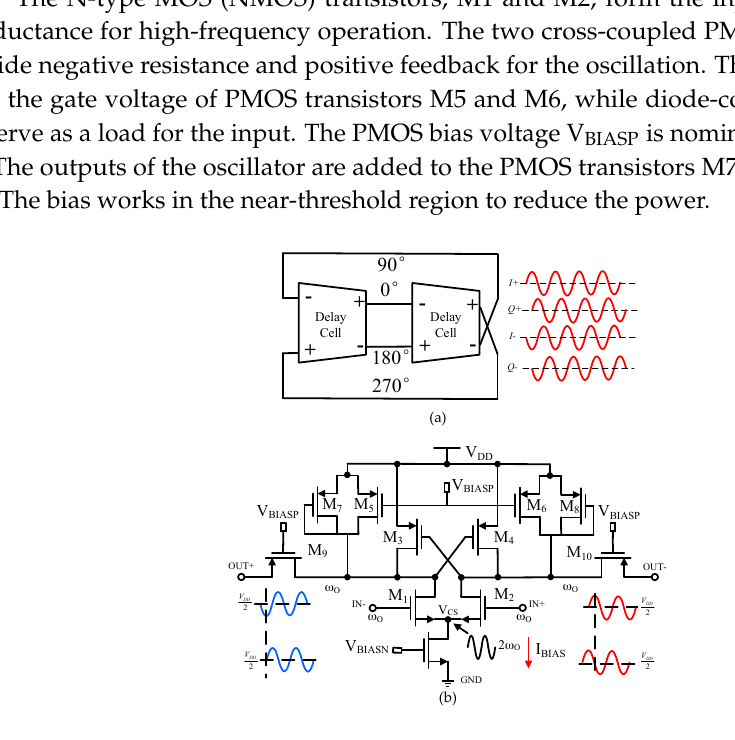
Figure 1. ( a ) Block-level diagram and ( b ) circuit implementation of the proposed quadrature oscillator.